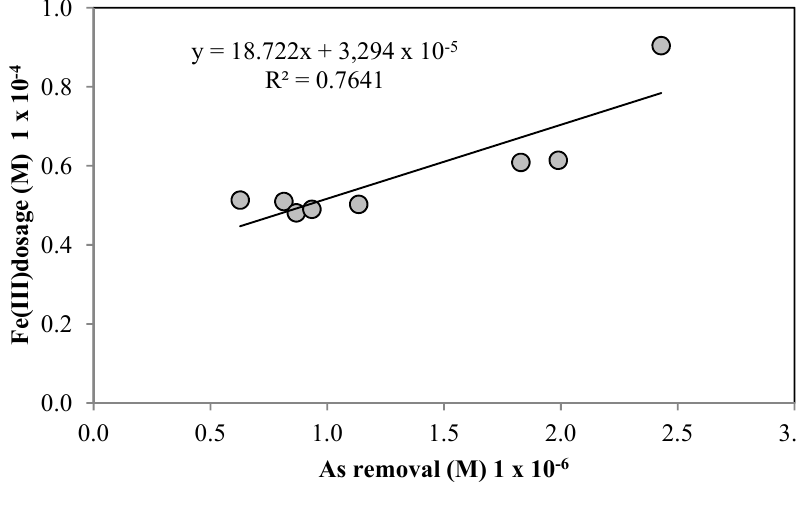
Figure 11. Correlation between Fe doses and As removal in full-scale NCMG plant.